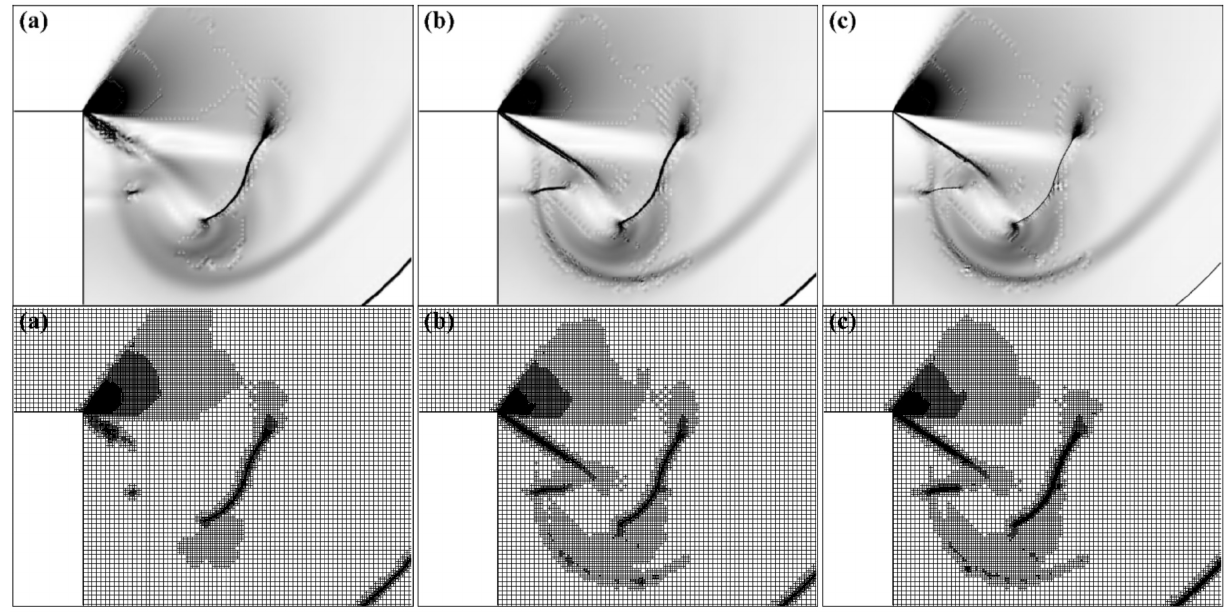
Fig. 2. Schlieren and corresponding mesh (a) Pressure-gradient adaptation (3 levels); (b) Density-gradient adaptation (3 levels); and (c) Density-gradient adaptation (5 levels).